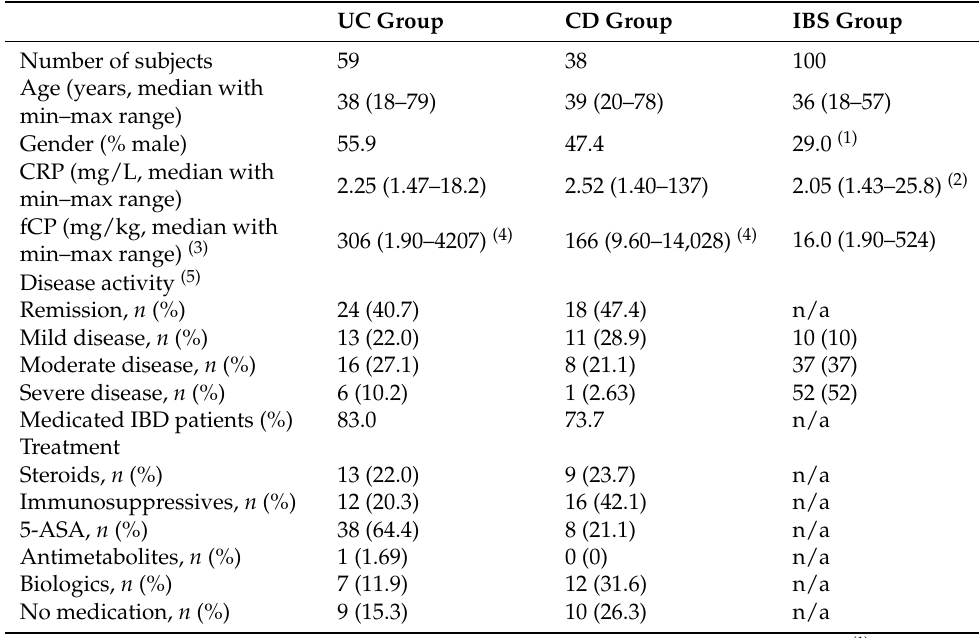
Table 1. Characteristics of